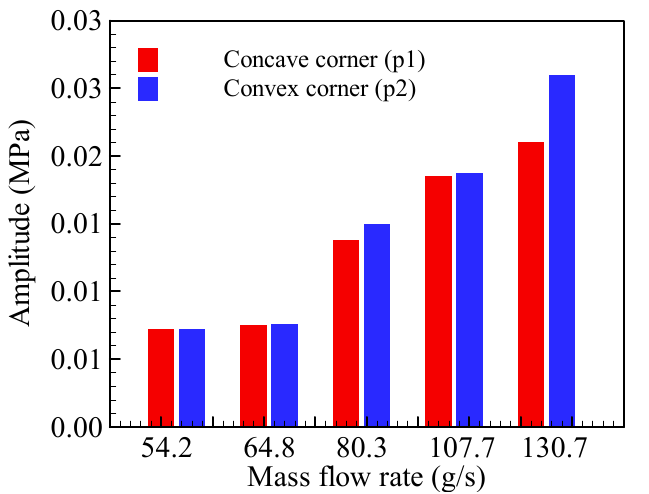
Figure 14. Dominant amplitudes of detonation pressure at the concave (p1) and convex (p2) corners of the outer wall of the combustion channel acquired from the FFT.